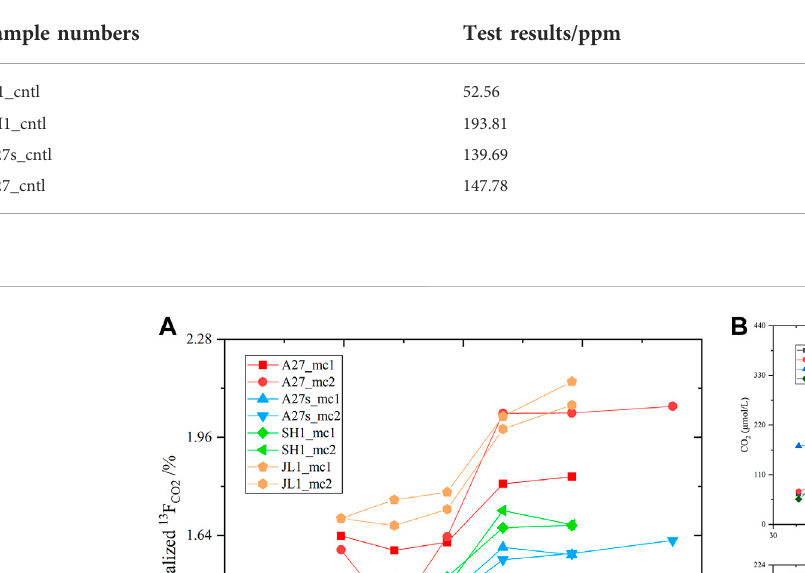
TABLE 2 Headspace CH 4 content and calculation of dissolved CH 4 in the control groups.